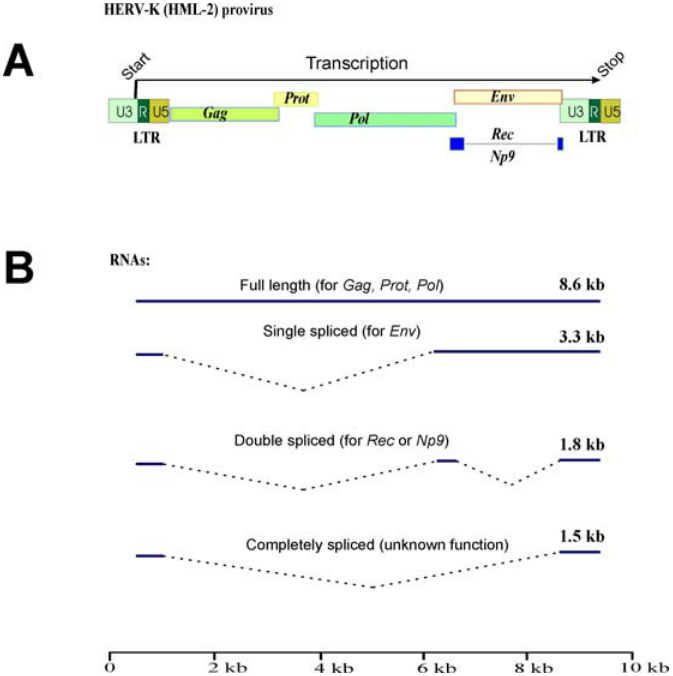
FIGURE 4. Functional genes, encoded by HERV-K (HML-2) endogenous retroviruses. (A) Genomic organization of the reconstituted full-size functional provirus. Apart from “classical” retroviral genes Gag , Prot , Pol , and Env ,